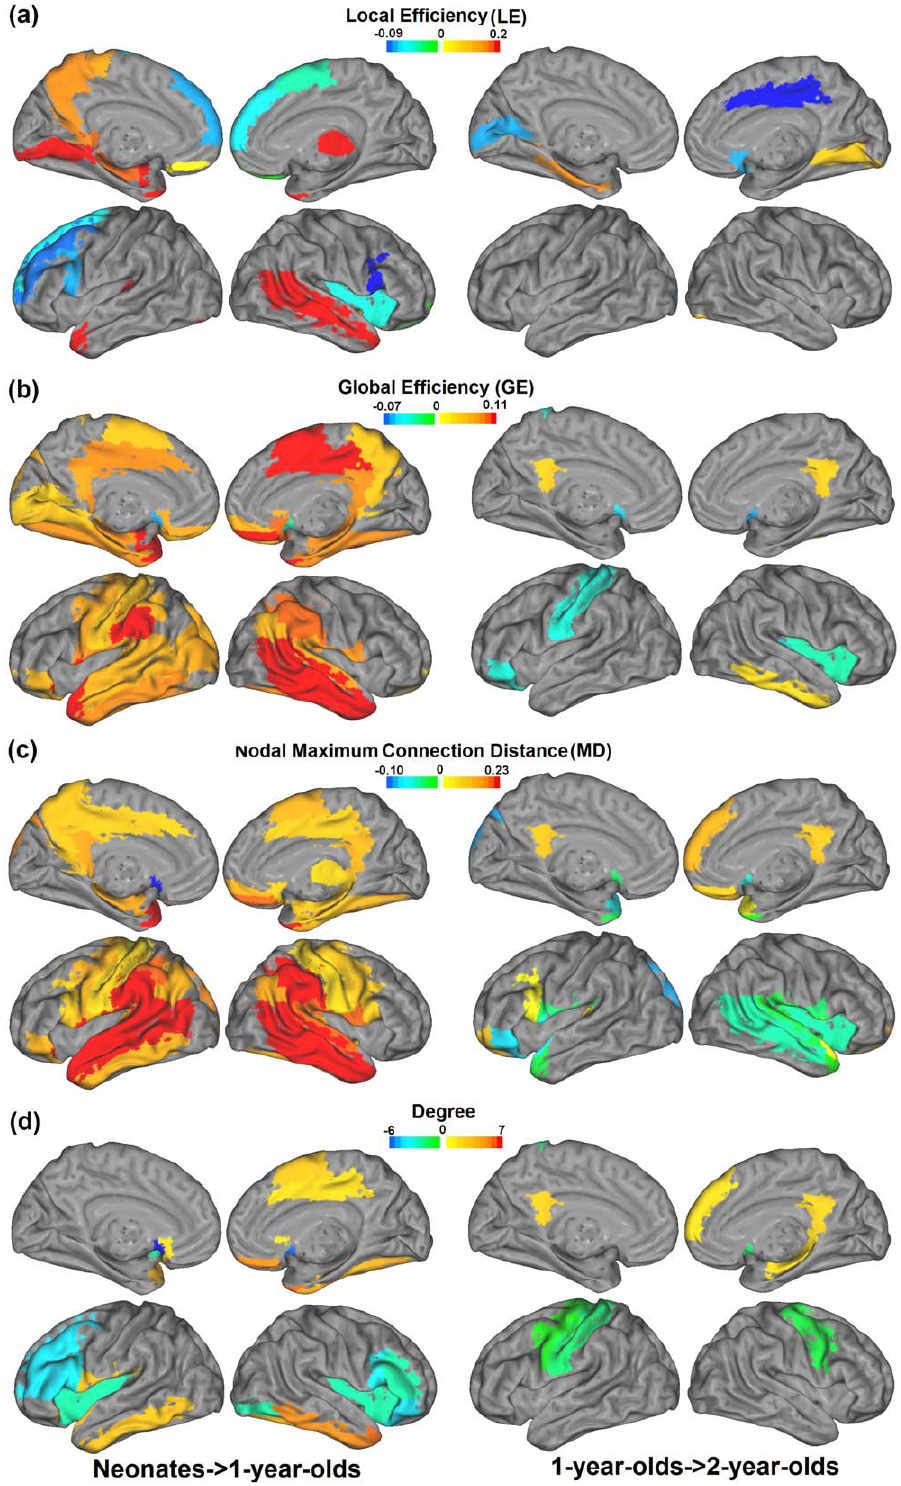
Figure 3. Regional developments of LE (a), GE (b), nodal maximum connection distance (MD) (c) and Degree (d). Both regional increase (represented by yellow to red colors) and decrease (represented by green to blue colors) are shown on the same brain surface. The left column shows the changes from neonates to 1 yr olds while the right column shows the changes from 1 yr to 2 yr olds.